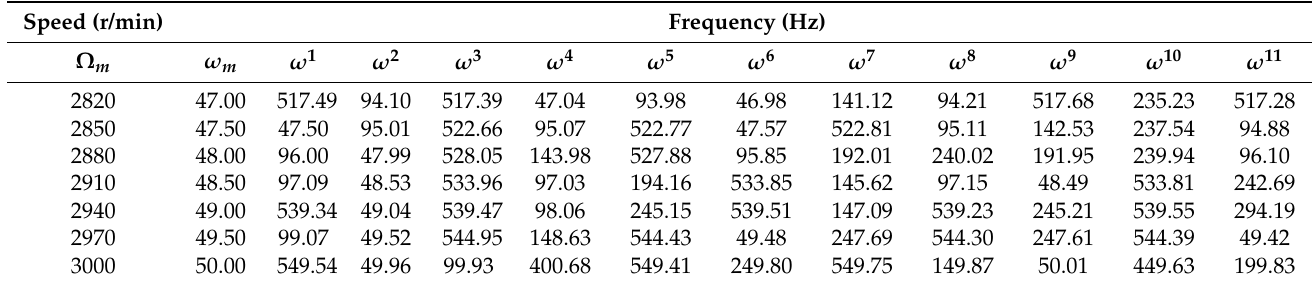
error is very small, since for the worst case, it is under 0.08%. The standard deviation of the relative error in the estimation of the speed from the individual peak frequencies is also very small, always under 0.03 Hz (fifteen audio recordings were considered for the calculation of the standard deviation in each case). Table 3. No load coupled to the motor shaft: the rotor shaft mechanical frequency and the values of the frequencies Table 4. No load coupled to the motor shaft: estimated speeds and frequencies, relative errors, and standard deviations. corresponding to the 11 peaks of the magnitude of the spectrum of the noise signal. Experimental Algorithm Relative Error Standard Deviation Speed (r/min)